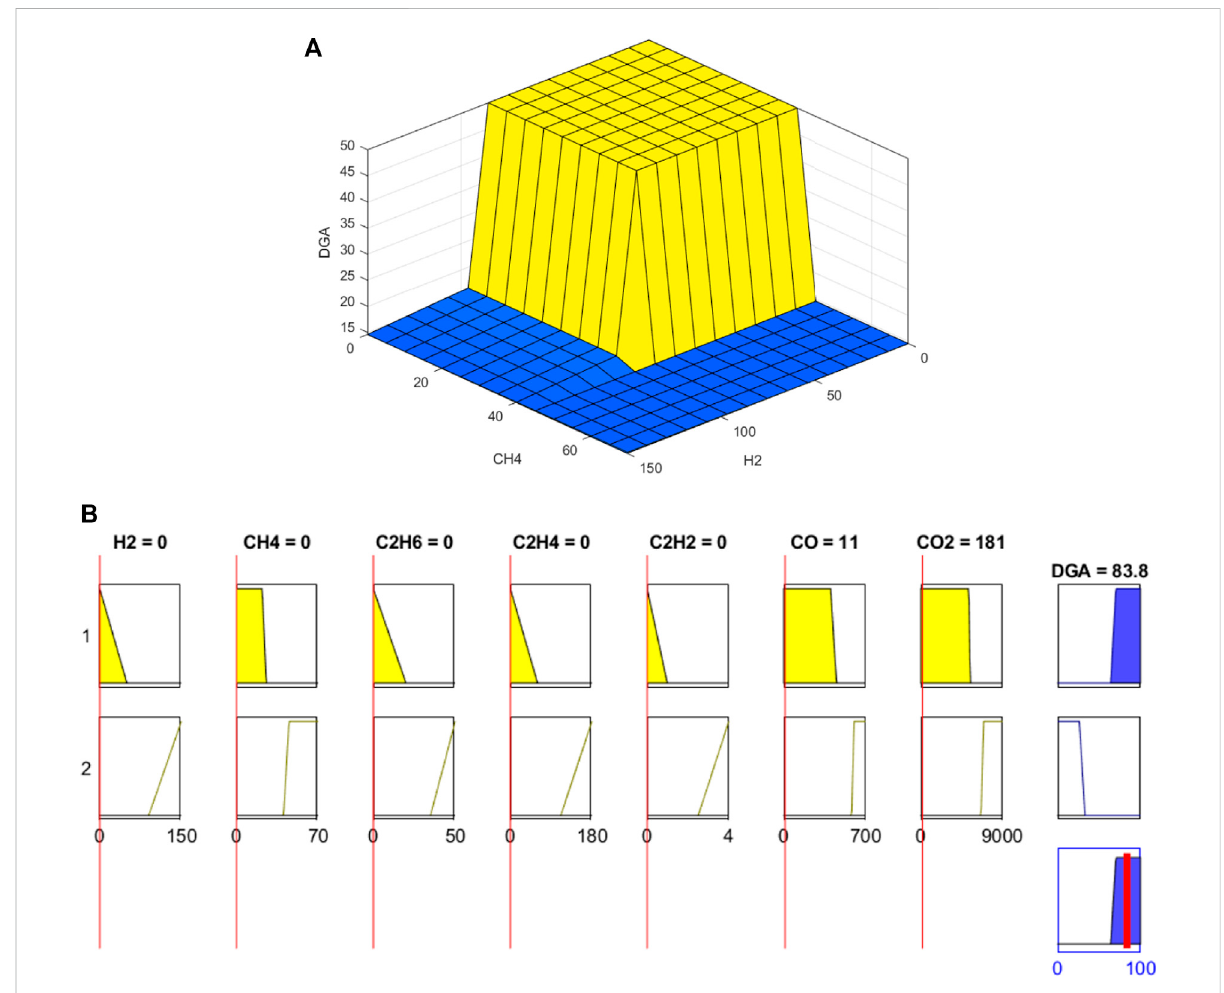
FIGURE 4 (A) Surface formed for DGA. (B) Rules used in fuzzy sublogic for DGA.